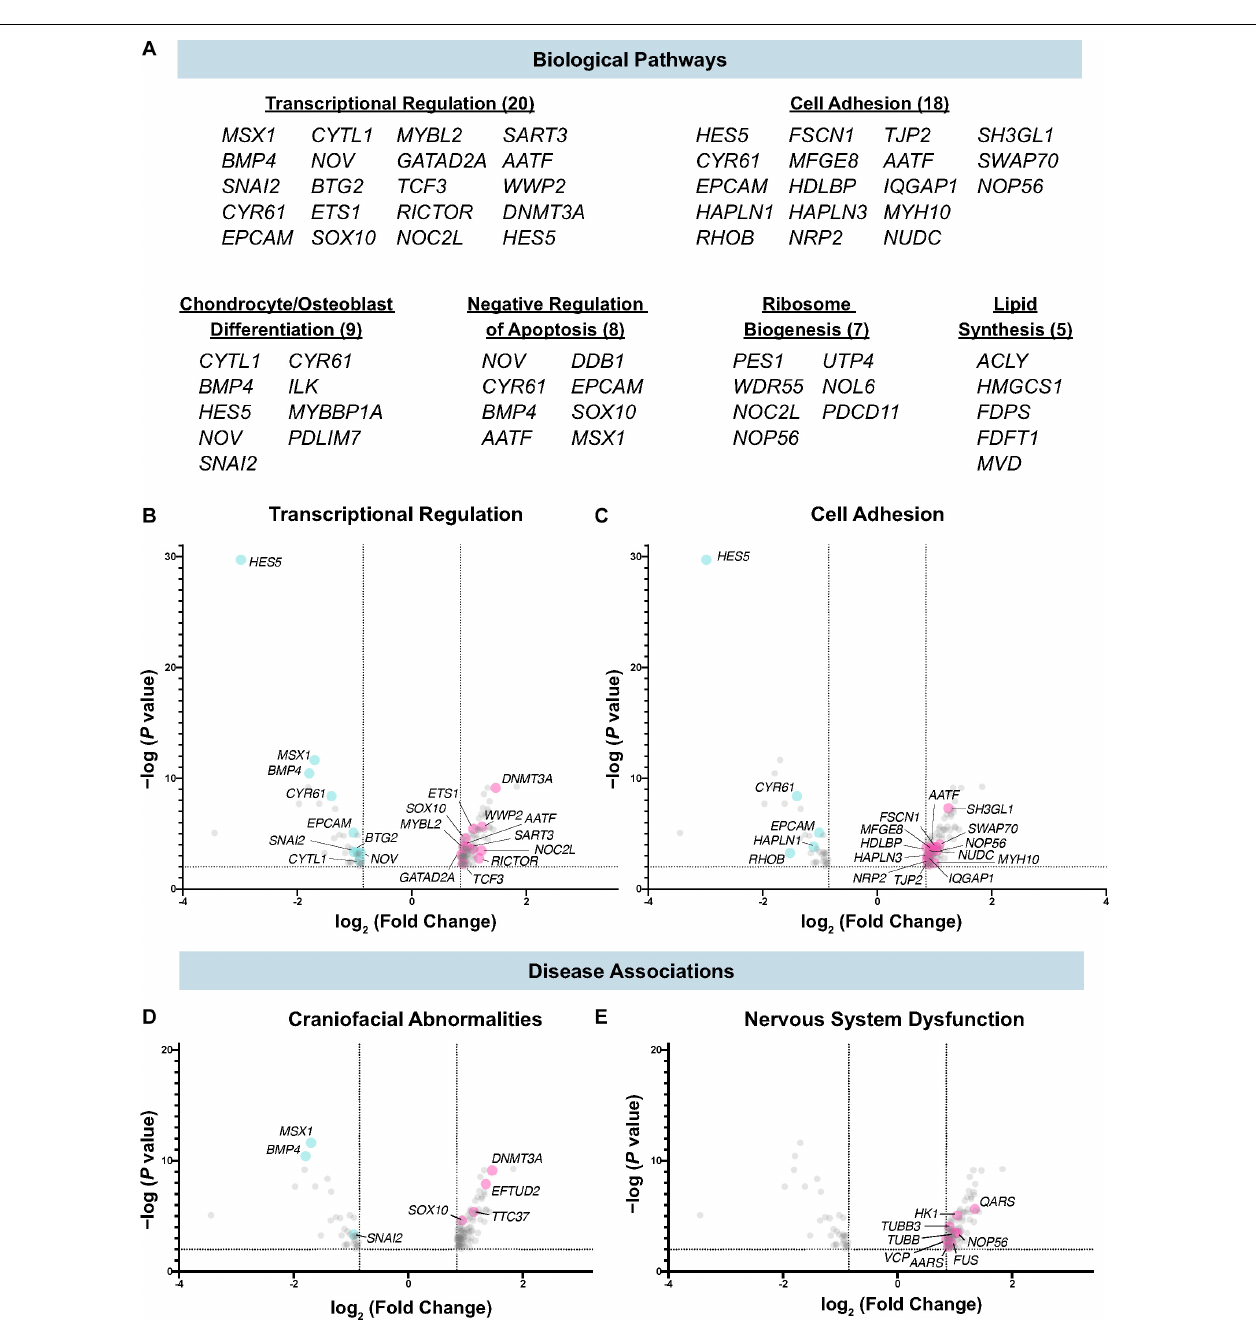
FIGURE 3 | Biological pathways and diseases associated with Draxin-responsive transcriptome dataset. (A–C) Biological pathway analysis identified enrichment of targets associated with transcriptional regulation, cell adhesion, chondrocyte/osteoblast differentiation, negative regulation of apoptosis, ribosome biogenesis, and lipid synthesis. (D,E) Functional annotation identified genes highly correlated with craniofacial abnormalities and nervous system